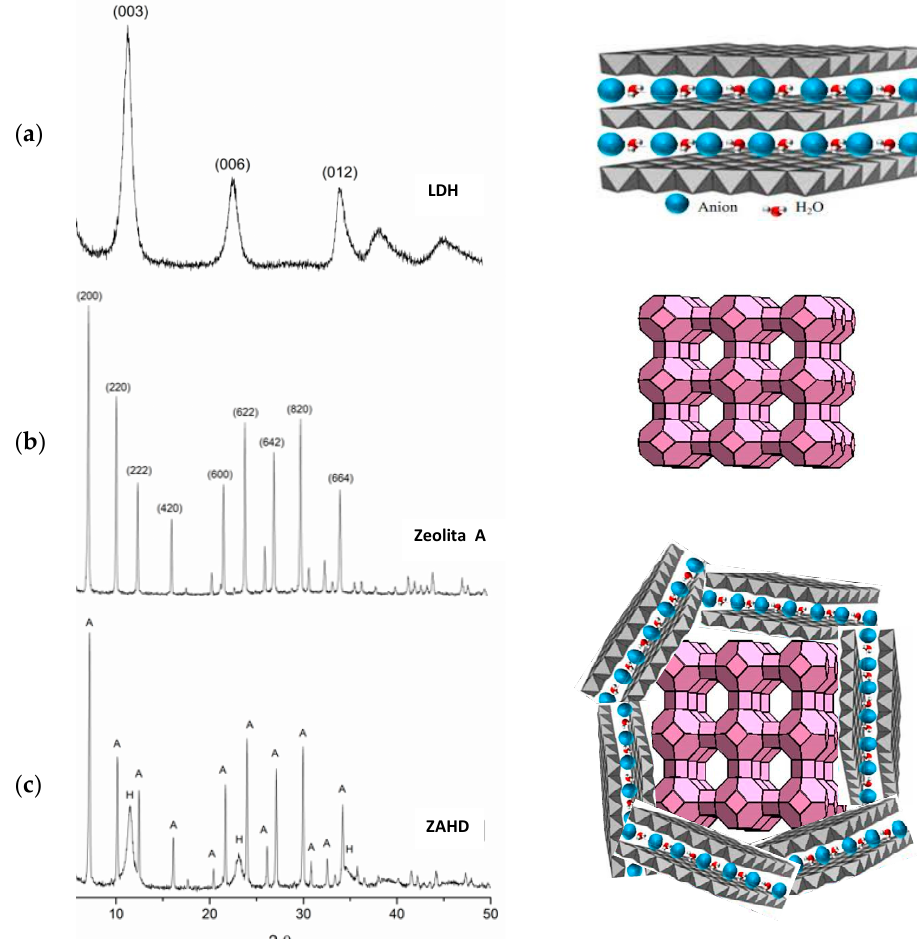
Figure 1. Diffractograms of the structure scheme of the synthesized materials: ( a ) LDH, ( b ) zeolite A, and ( c ) ZAHD composite.